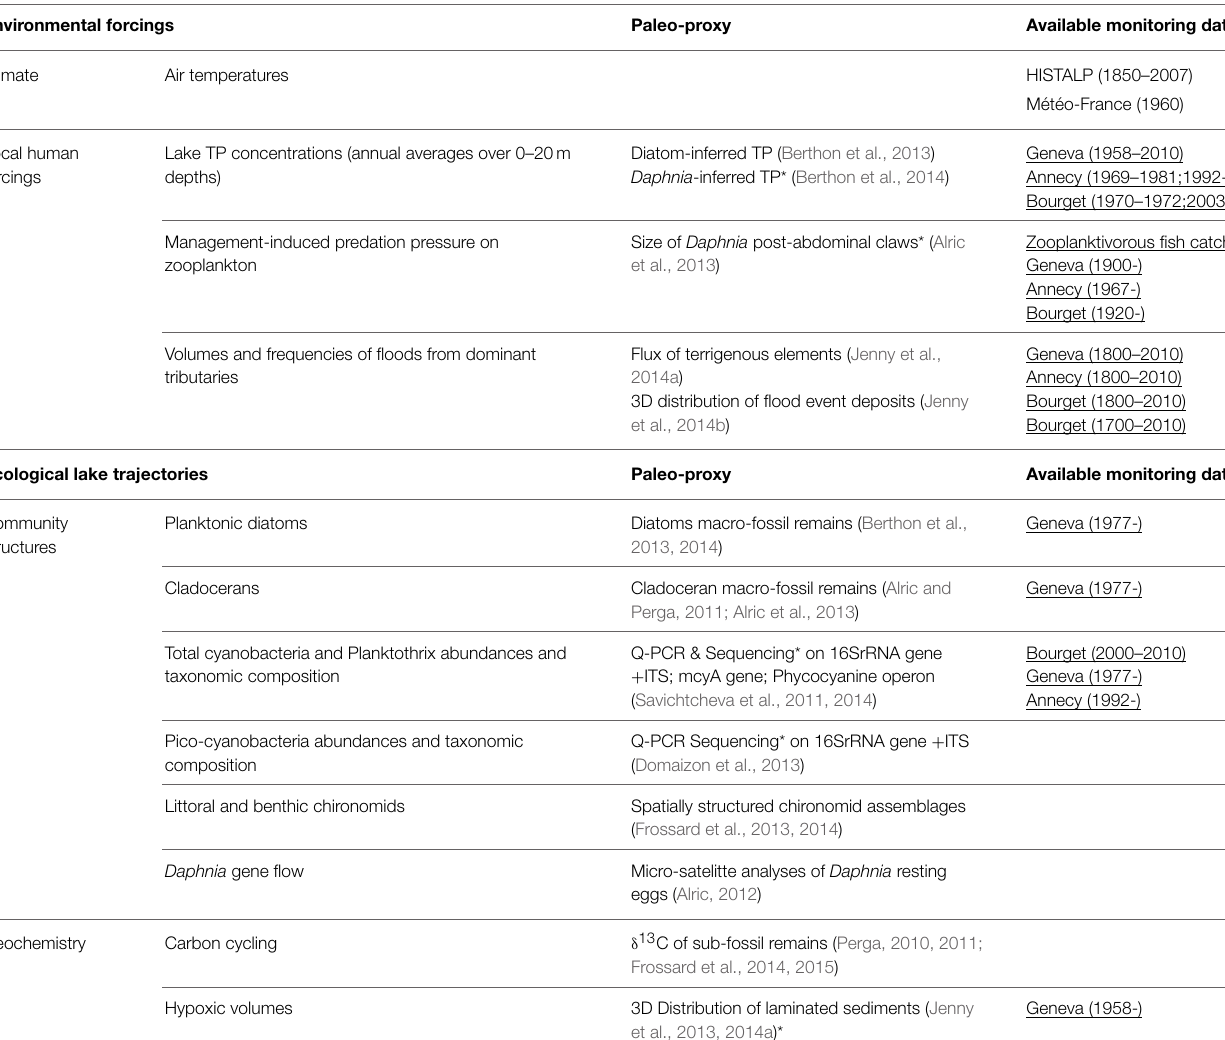
TABLE 1 | Summary of neo- and palaeo-ecological data used to infer the dynamics of climate and local forcings and ecological trajectories of lakes Geneva, Annecy, and Bourget over the last 200